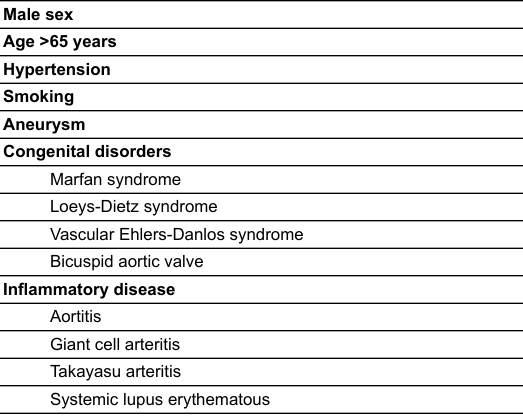
Table 1: Risk factors for aortic